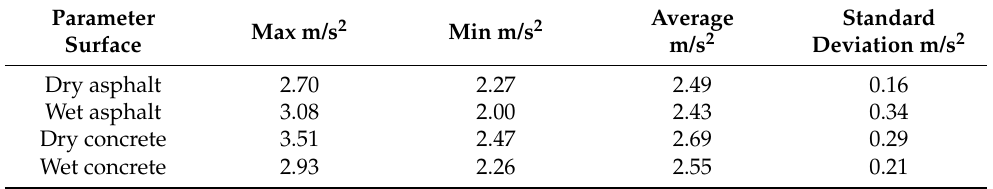
Table 5. Statistical characteristics of the acceleration value in the coach acceleration maneuvers.